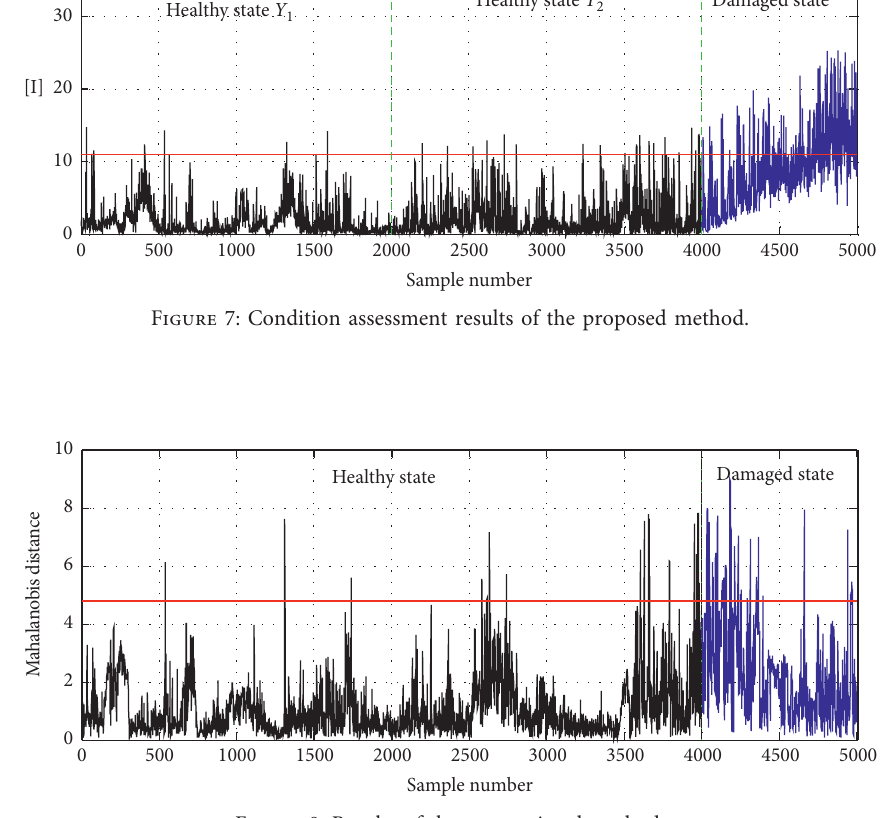
Figure 8: Results of the conventional method.